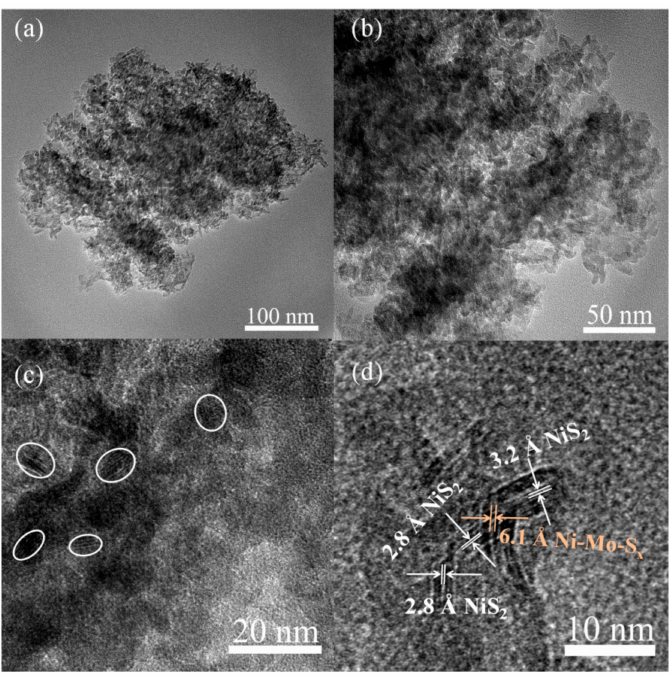
Figure 3. TEM and HR-TEM images of the 5Ni-3Mo / Al 2 O 3 catalyst ( a ) scaleplate of 100 nm; ( b ) scaleplate of 50 nm; ( c ) scaleplate of 20 nm; ( d ) scaleplate of 10 nm.